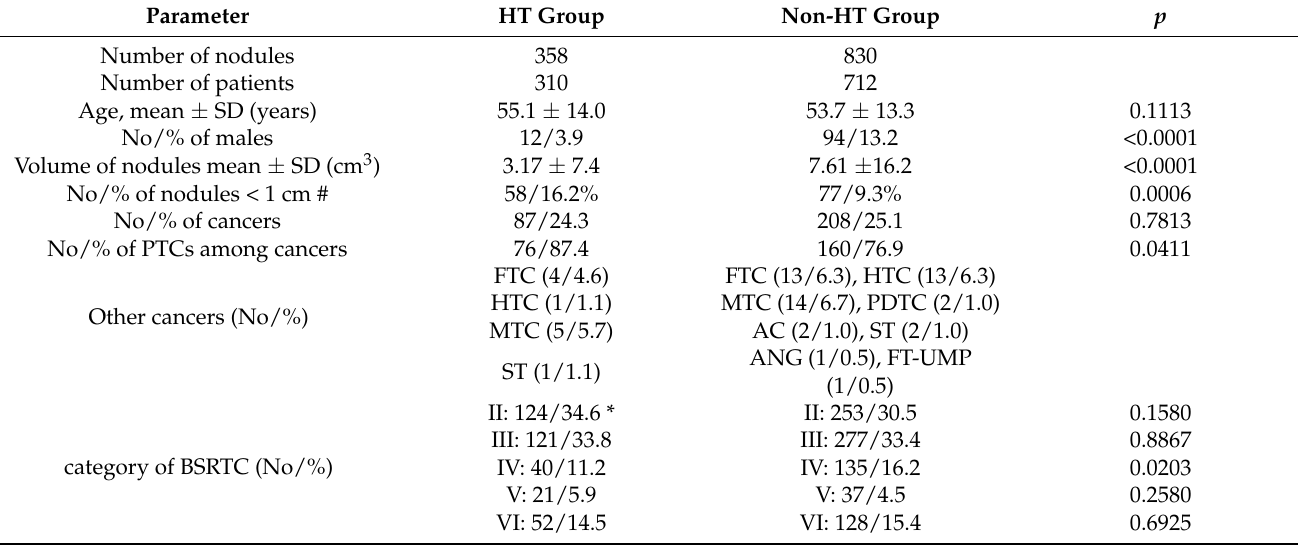
Table 5. Data on the diagnostic effectiveness of analyzed SRSs in HT and non-HT groups for the high risk category (nodule’s shape evaluated on the transverse